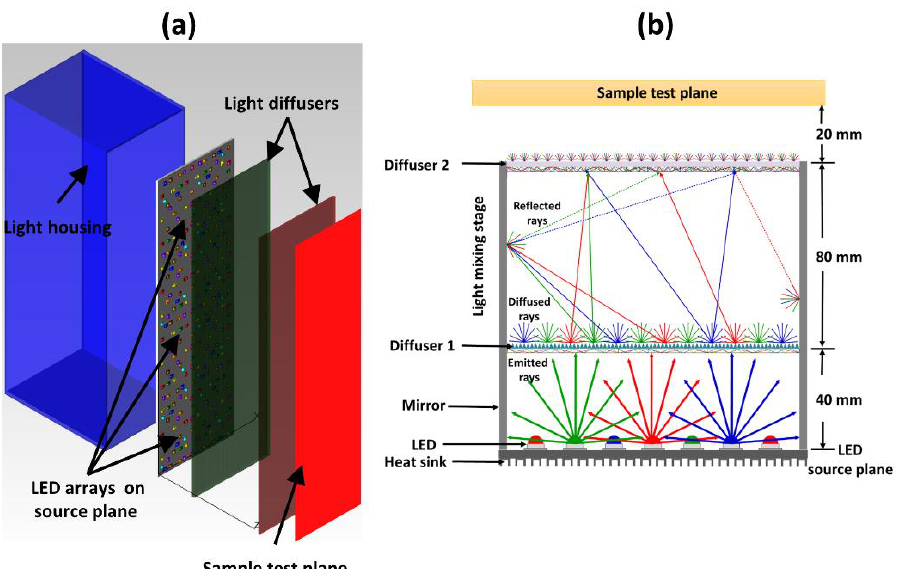
Figure 4. ( a ) The LED LASS modular arrangement as modeled in the TracePro ® software. The light housing is shown in blue, the LED arrays are on the SP, the two light diffusers are shown in green and brown, and the sample test plan is shown in red. ( b ) The light enclosure designed with dual diffuser stages illustrates the light mixing stages to improve the SNI at the STP by two diffusers: a prismatic patterned (Diffuser1) and micro-structured (Diffuser 2). The side mirrors enhance the uniformity by reflecting the secondary rays toward diffuser 2.